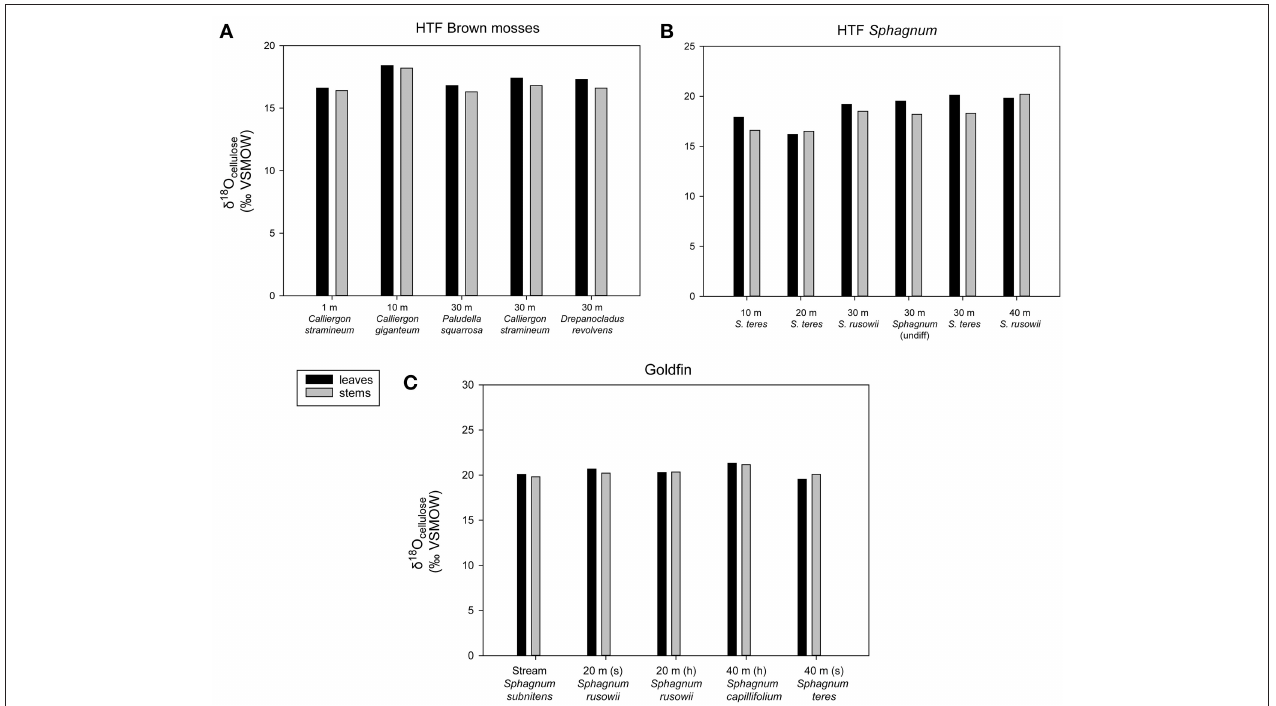
FIGURE 3 | Intra-plant δ 18 O cellulose values along the two transects (A) HTF brown mosses, (B) HTF Sphagnum mosses, (C) GF Sphagnum mosses. Each sample had one replicate with an analytical error of < 0.3 ‰ . All brown mosses and Sphagnum mosses found in Tables 2 , 3 are included. “(s)” refers to submerged, “(h)” refers to